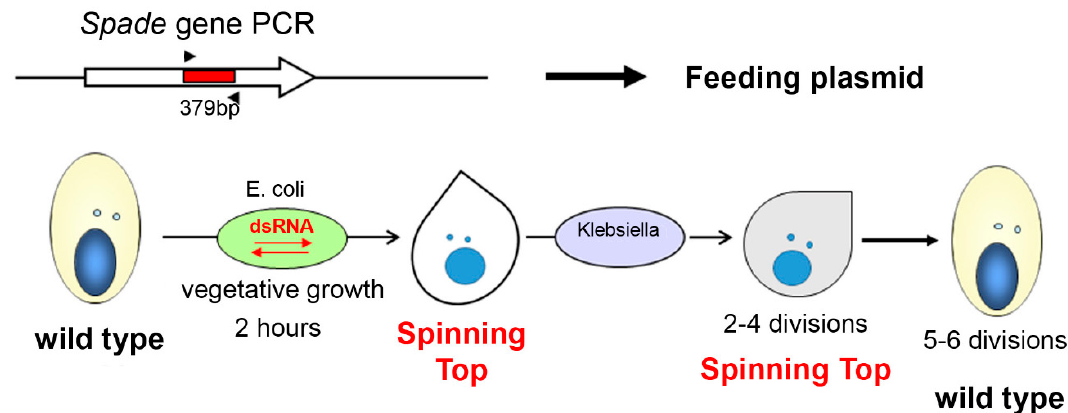
Figure 3. The scheme of Spade gene knockdown in vegetative P. tetraurelia cells by dsRNA feeding. The PCR amplicon of a target sequence was inserted into a feeding plasmid, which was then used for E. coli transformation. Ciliates feeding on transformed E. coli stop expressing the target gene until silencing is over. Analogous procedure was applied for copine and NimA genes, and had no phenotypic effect.